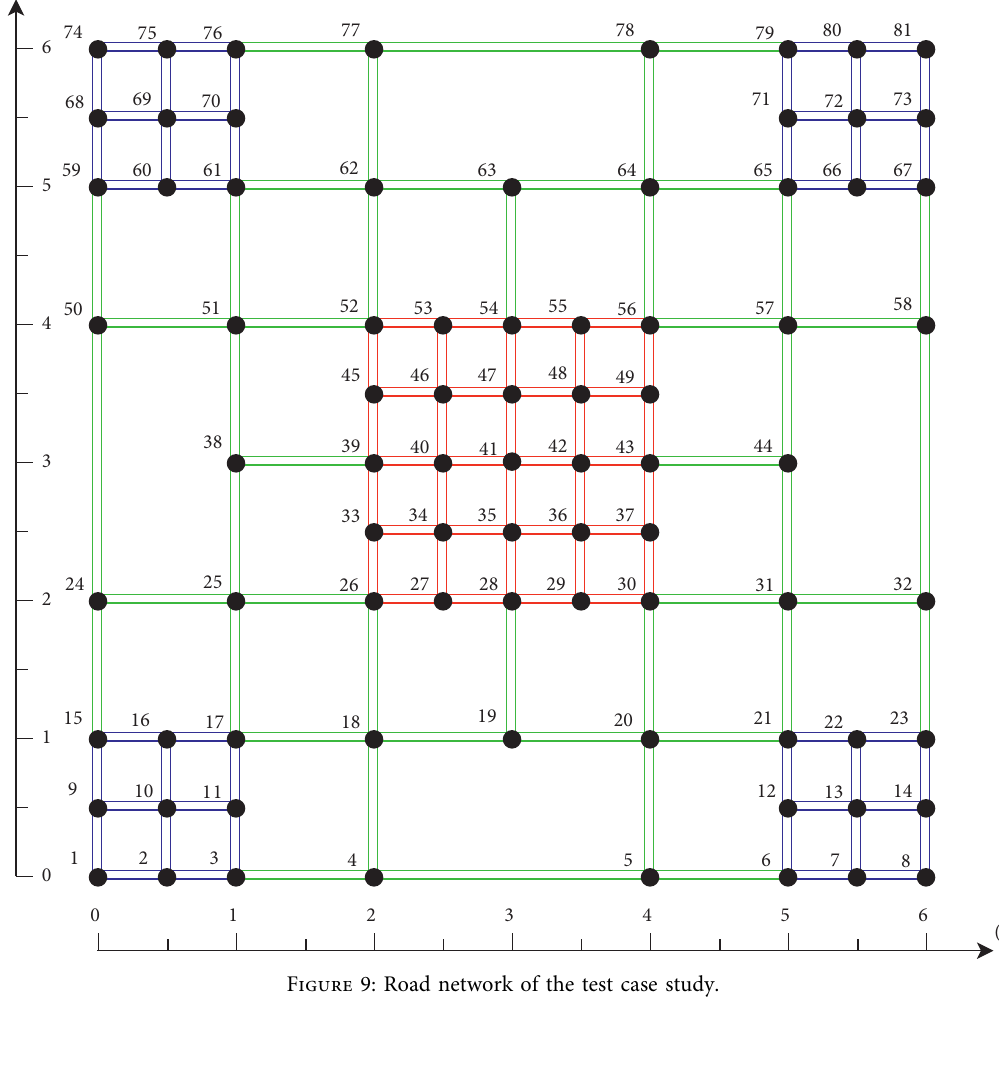
Figure 9: Road network of the test case